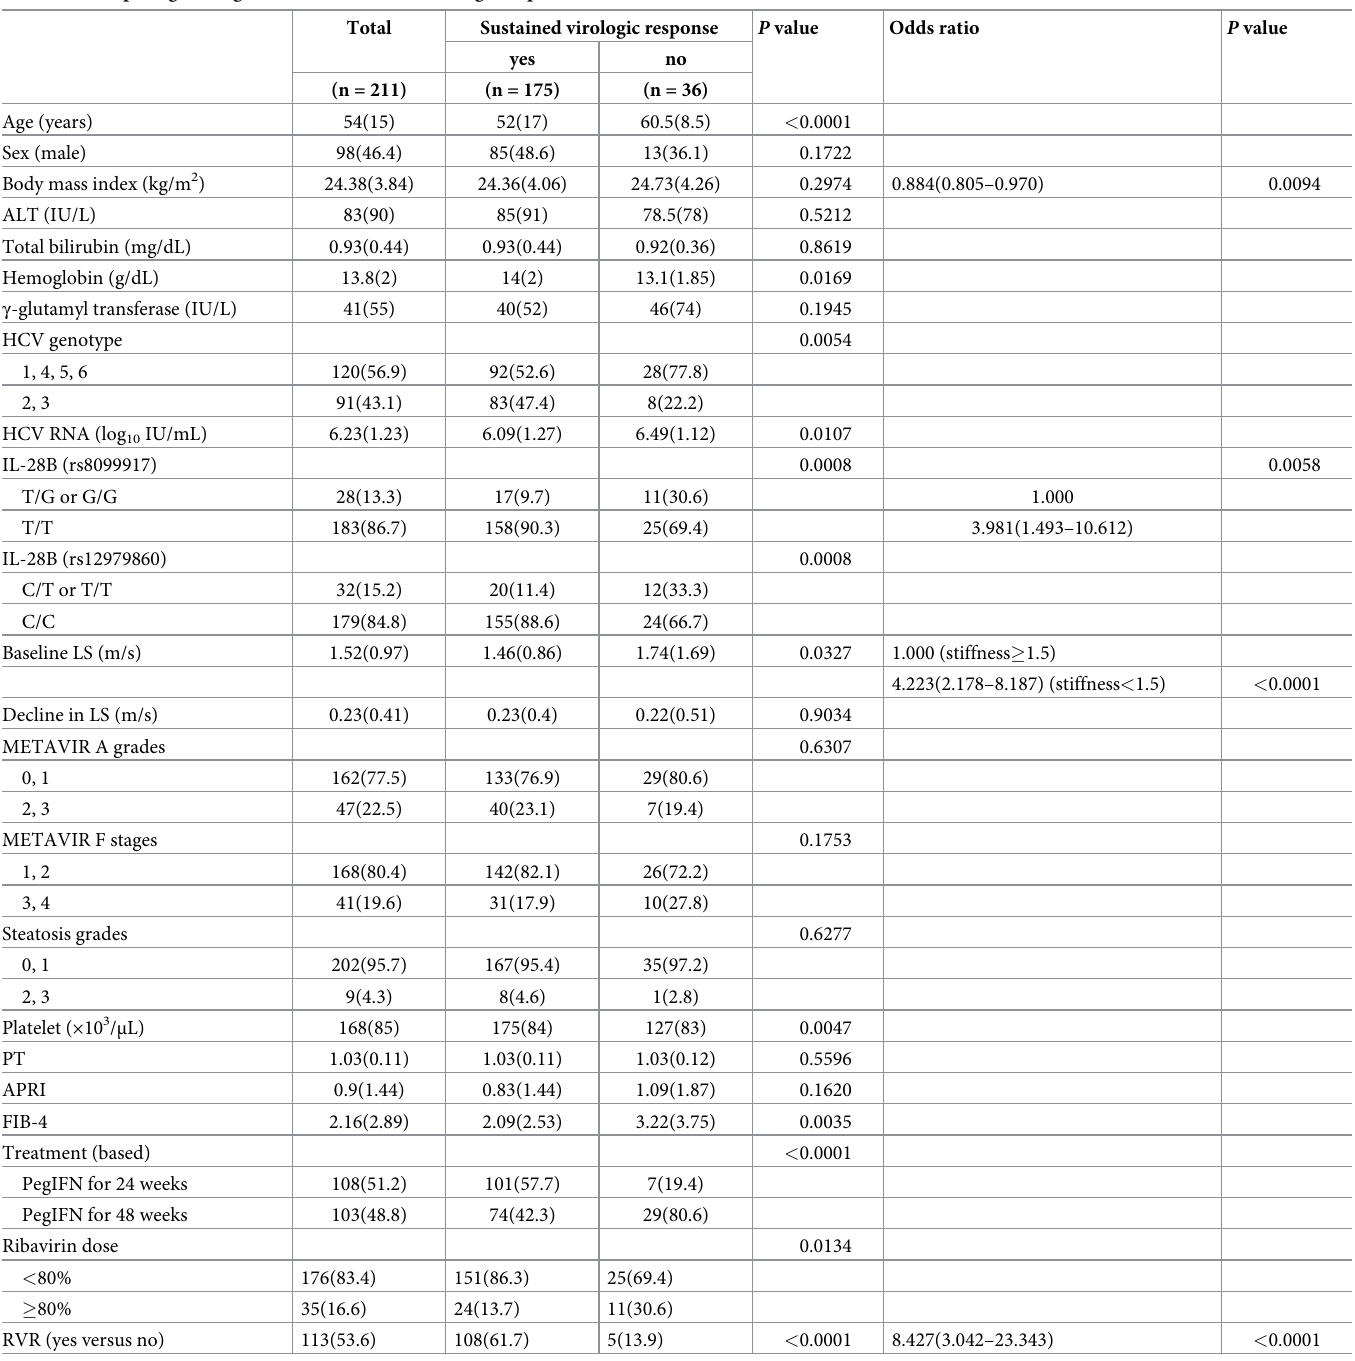
Table 5. Multiple logistic regressions for sustained virologic response